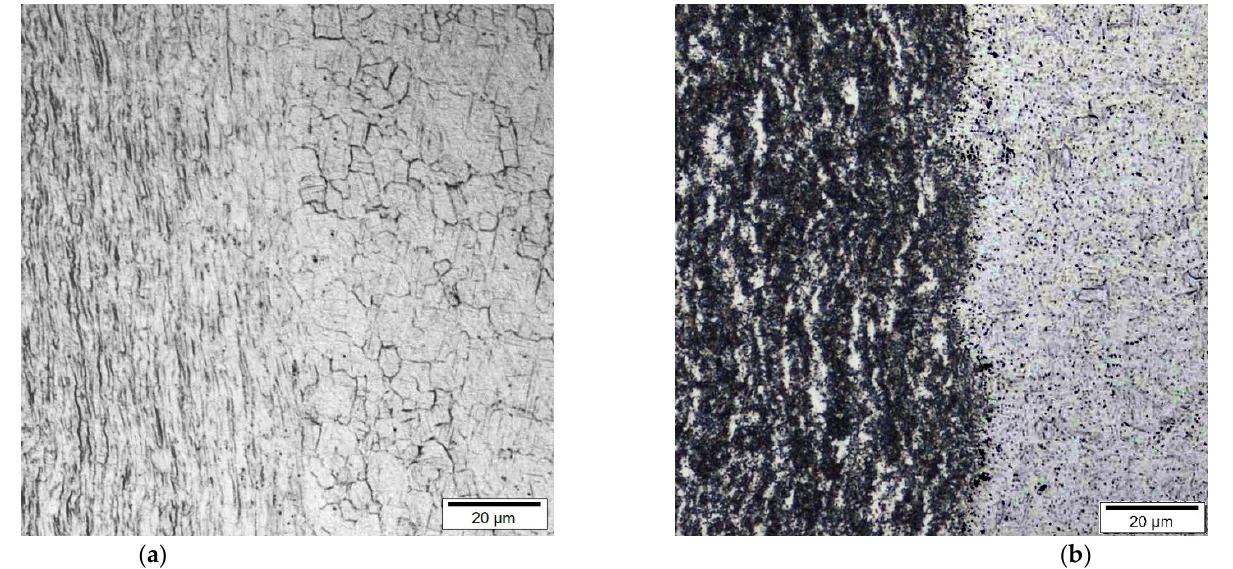
Figure 5. Microstructures in the WC at the weld line in the dissimilar Ti6242 − Ti64 linear friction welds: ( a ) AWed condition and ( b ) SRAed condition.